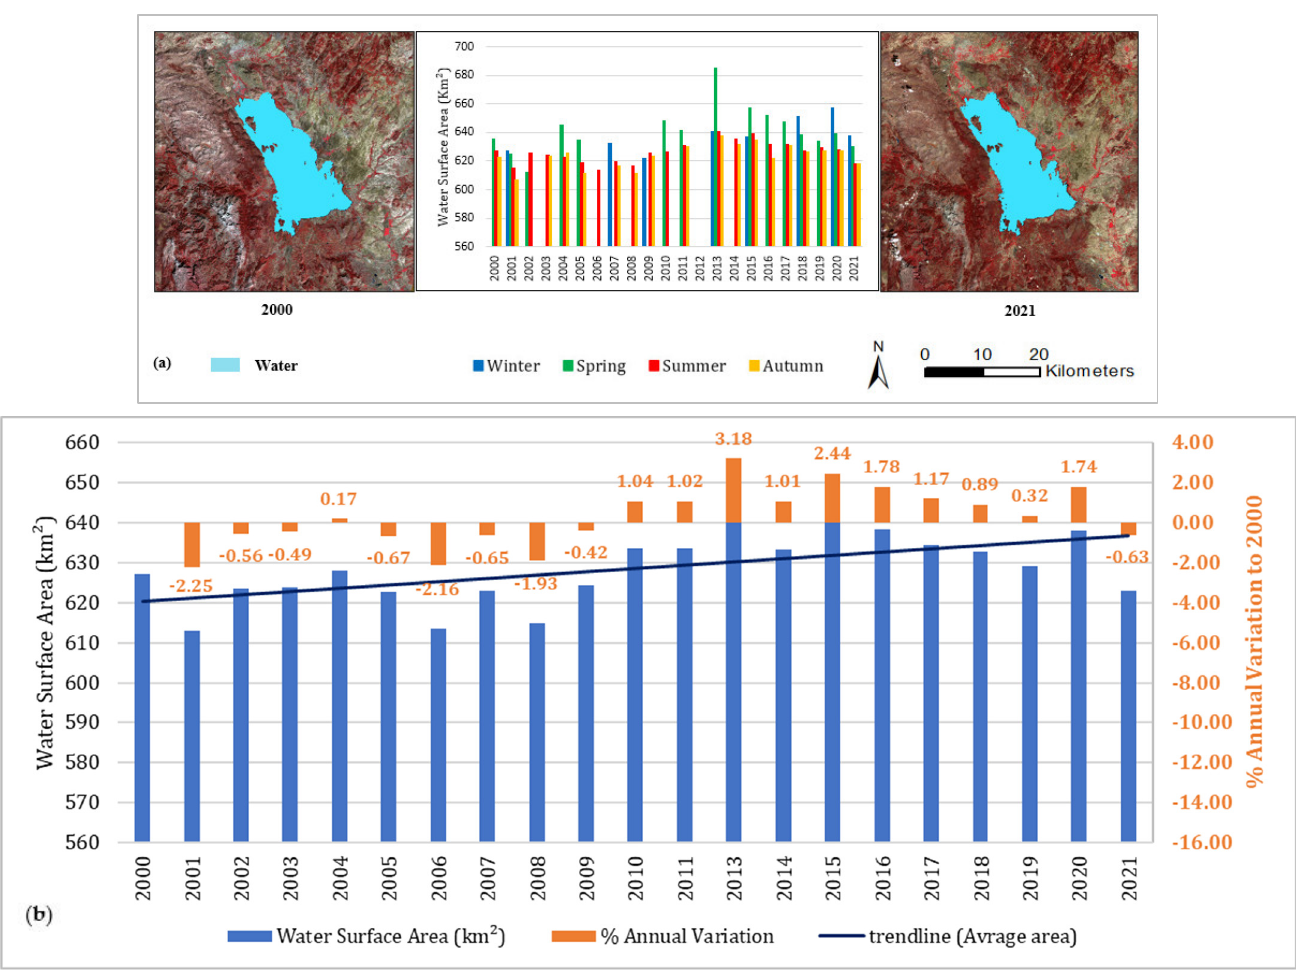
Figure 10. Beysehir Lake’s: ( a ) seasonal water surface area changes with RS images for 2000 and 2021; ( b ) long-term annual water surface area variation.